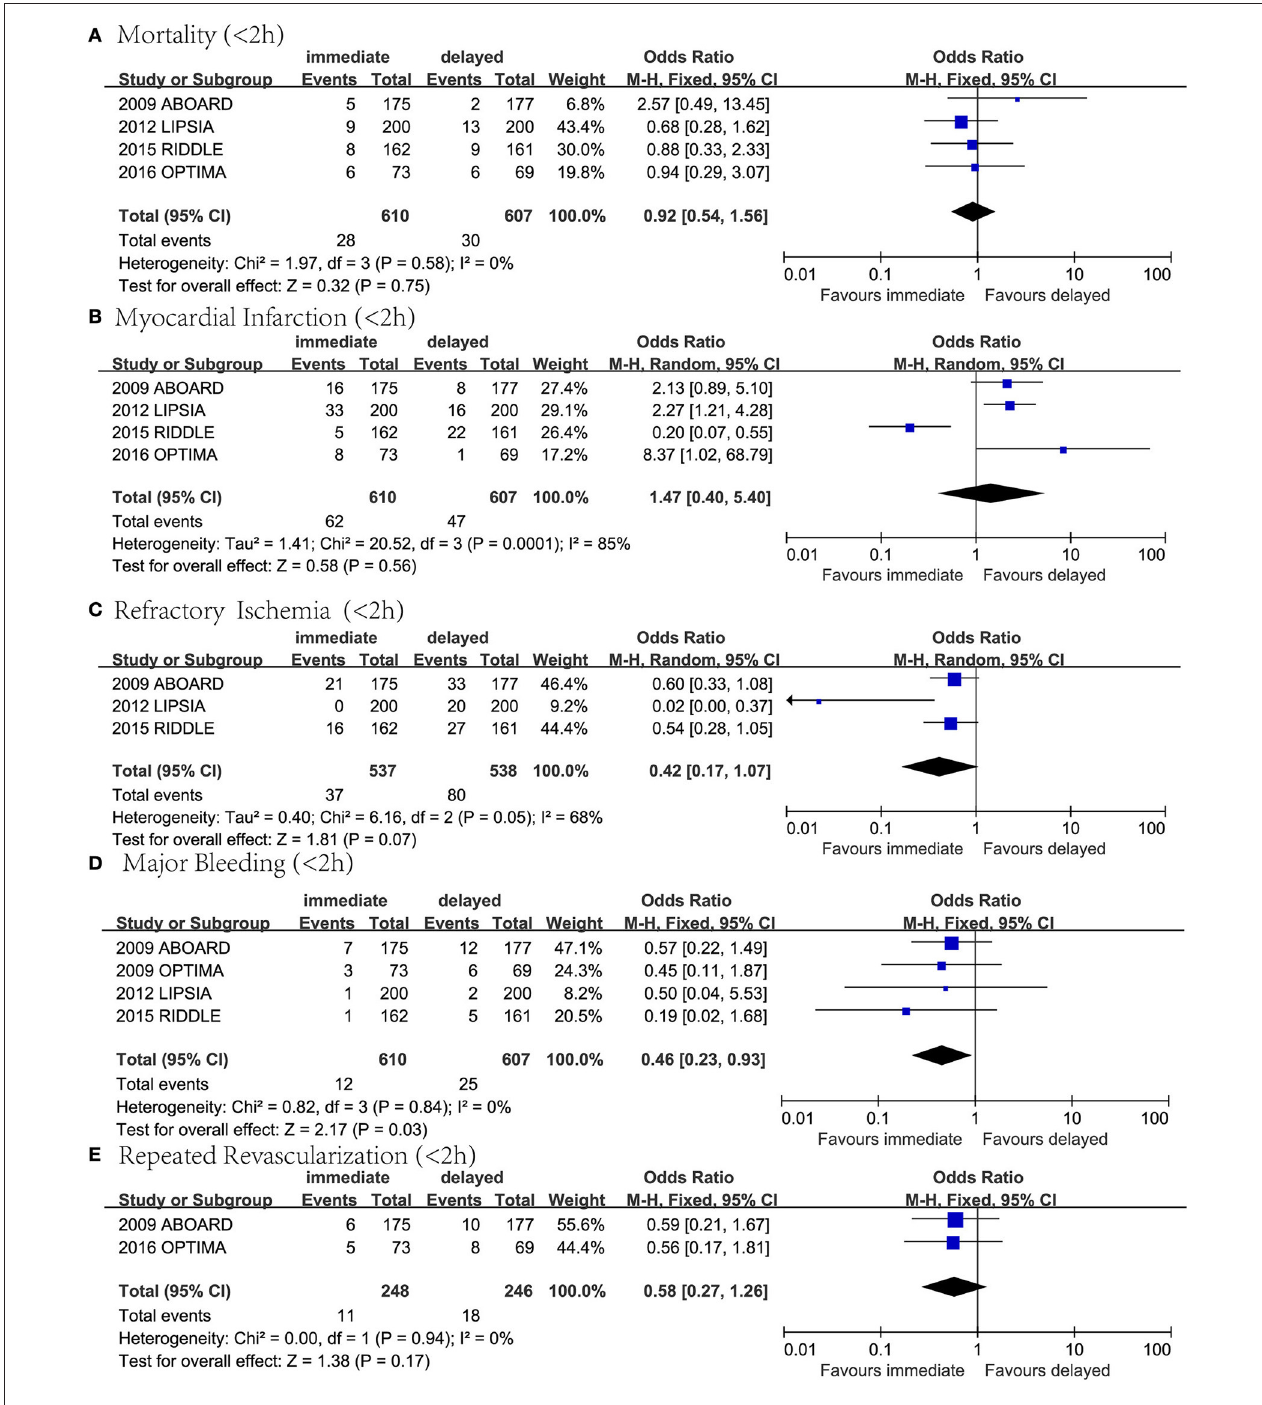
FIGURE 6 | Forest plots comparing outcomes between immediate ( < 2) invasive group and delayed invasive group. (A) Mortality, (B) myocardial infarction, (C) refractory ischemia, (D) major bleeding, and (E) repeated revascularization.